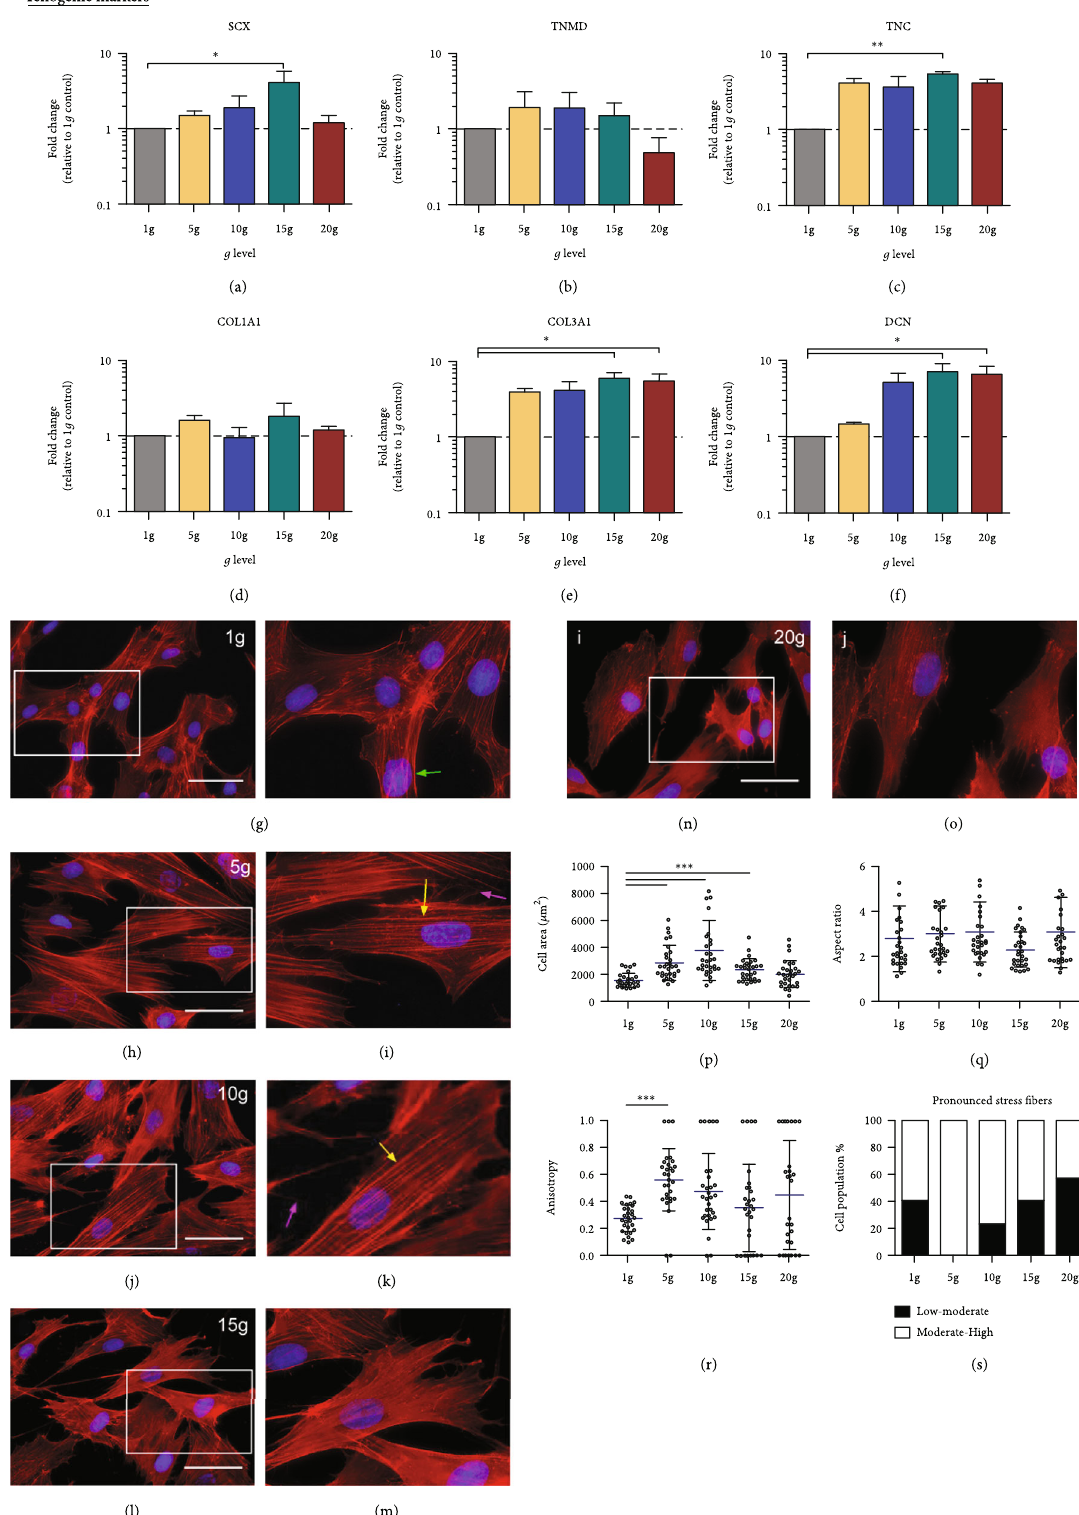
Figure 8: Transcription level of tendon-related genes: (a) SCX, (b) TNMD, (c) TNC, (d) COL1A1, (e) COL3A1, and (f) DCN. E ff ect of hypergravity at 16 h on morphology and F-actin distribution: (g – o) organization of F-action under normal and hyper-gravity conditions, (p, q) quanti fi cation of cell surface area, (r) measurement of anisotropy, and (s) quanti fi cation of stress fi bers in hTSCs. Reproduced with permission from reference